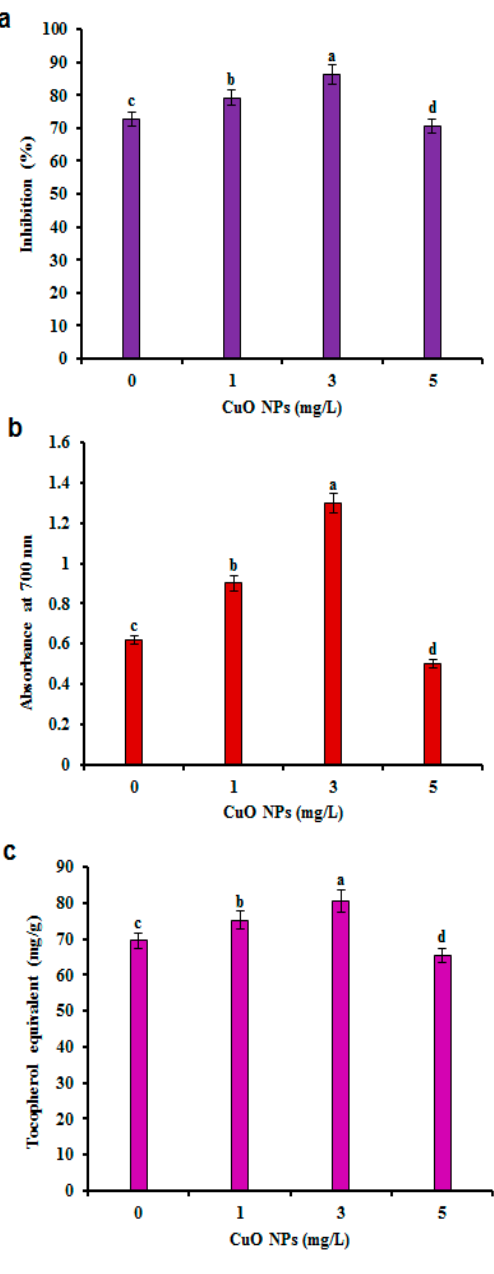
Figure 4. Effect of CuO NPs on antioxidant activities in CSC of G. sylvestre . ( a ) Free radical-scavenging activity by the 2,2-diphenyl-1-picryl-hydrazyl-hydrate (DPPH) assay, ( b ) total Fe 3+ – Fe 2+ reductive potential reference antioxidants (butylated hydroxytoluene), ( c ) total antioxidant capacity (TAC) by the phosphomolybdenum method. TAC is expressed as equivalents of α -tocopherol ( µ g / g of extract). Di ff erent letters indicate a significant di ff erence at p ≤